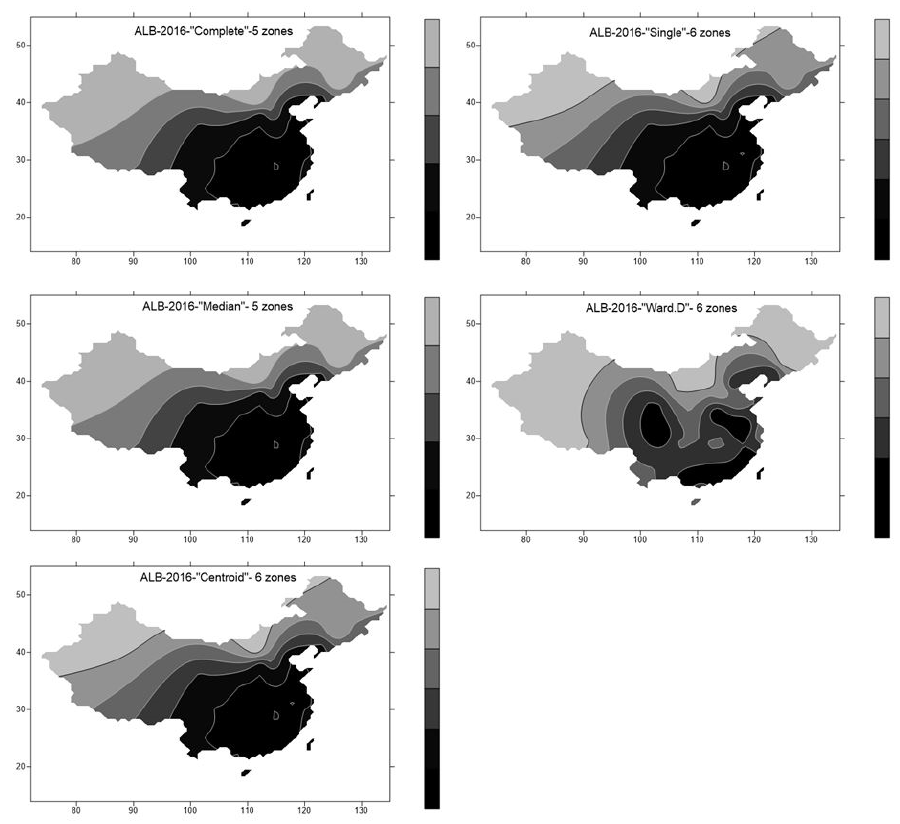
Figure 5. Classification of surface albedo (ALB) using 5 different methods (2016).